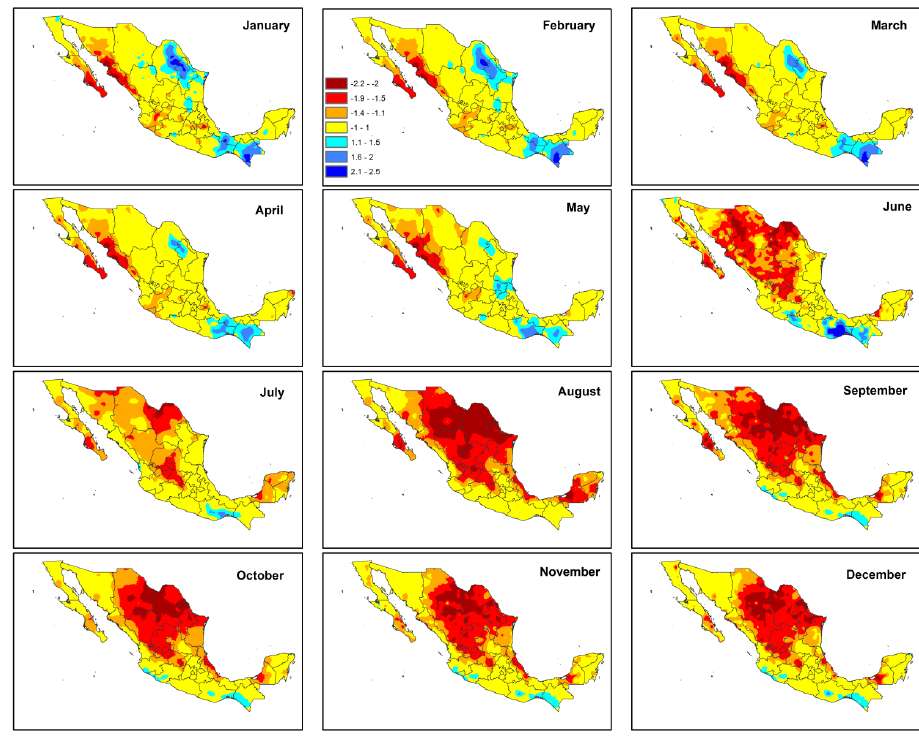
Figure 14. Drought monitoring based on TRMM 3B42 twelve-month Standardized Precipitation Index for 2011.